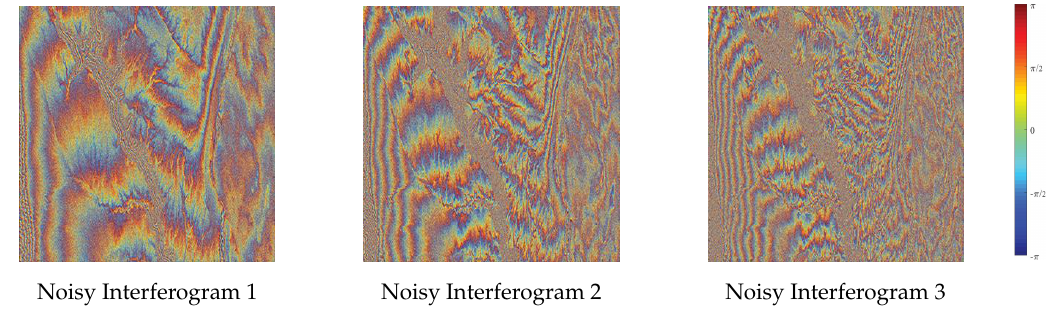
Figure 13. The real interferograms with different baseline (the length of baseline increase form left to right).